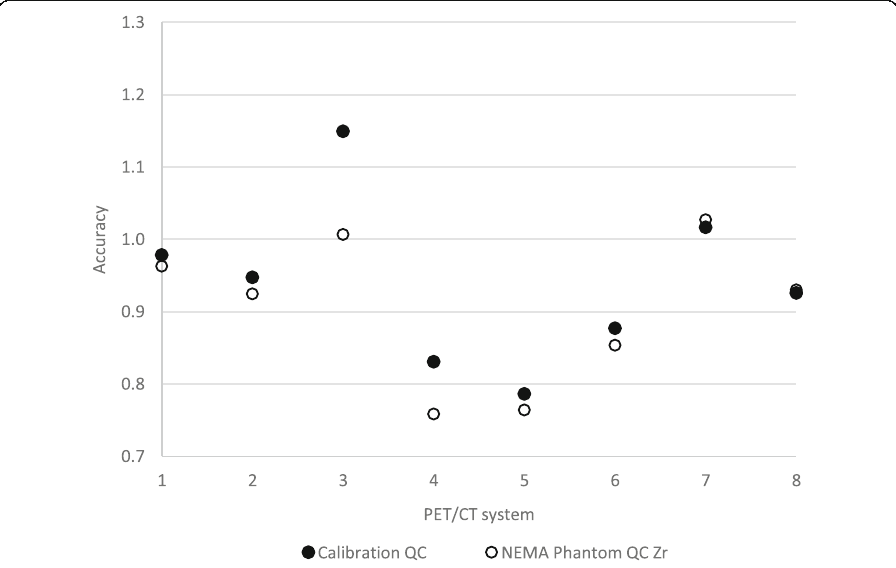
Fig. 2 SUV accuracy of the PET scanners relative to the dose calibrator measurements plotted by system number. Systems 1 – 2 and 3 – 4 represent GE scanners Discovery 690 and Discovery 710, respectively; systems 5 – 6